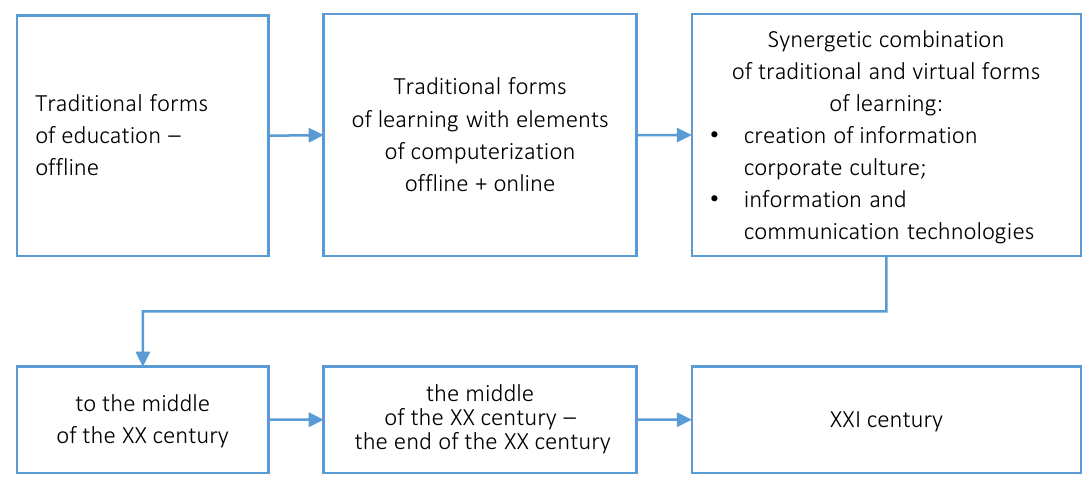
Figure 7. Transformation of education forms